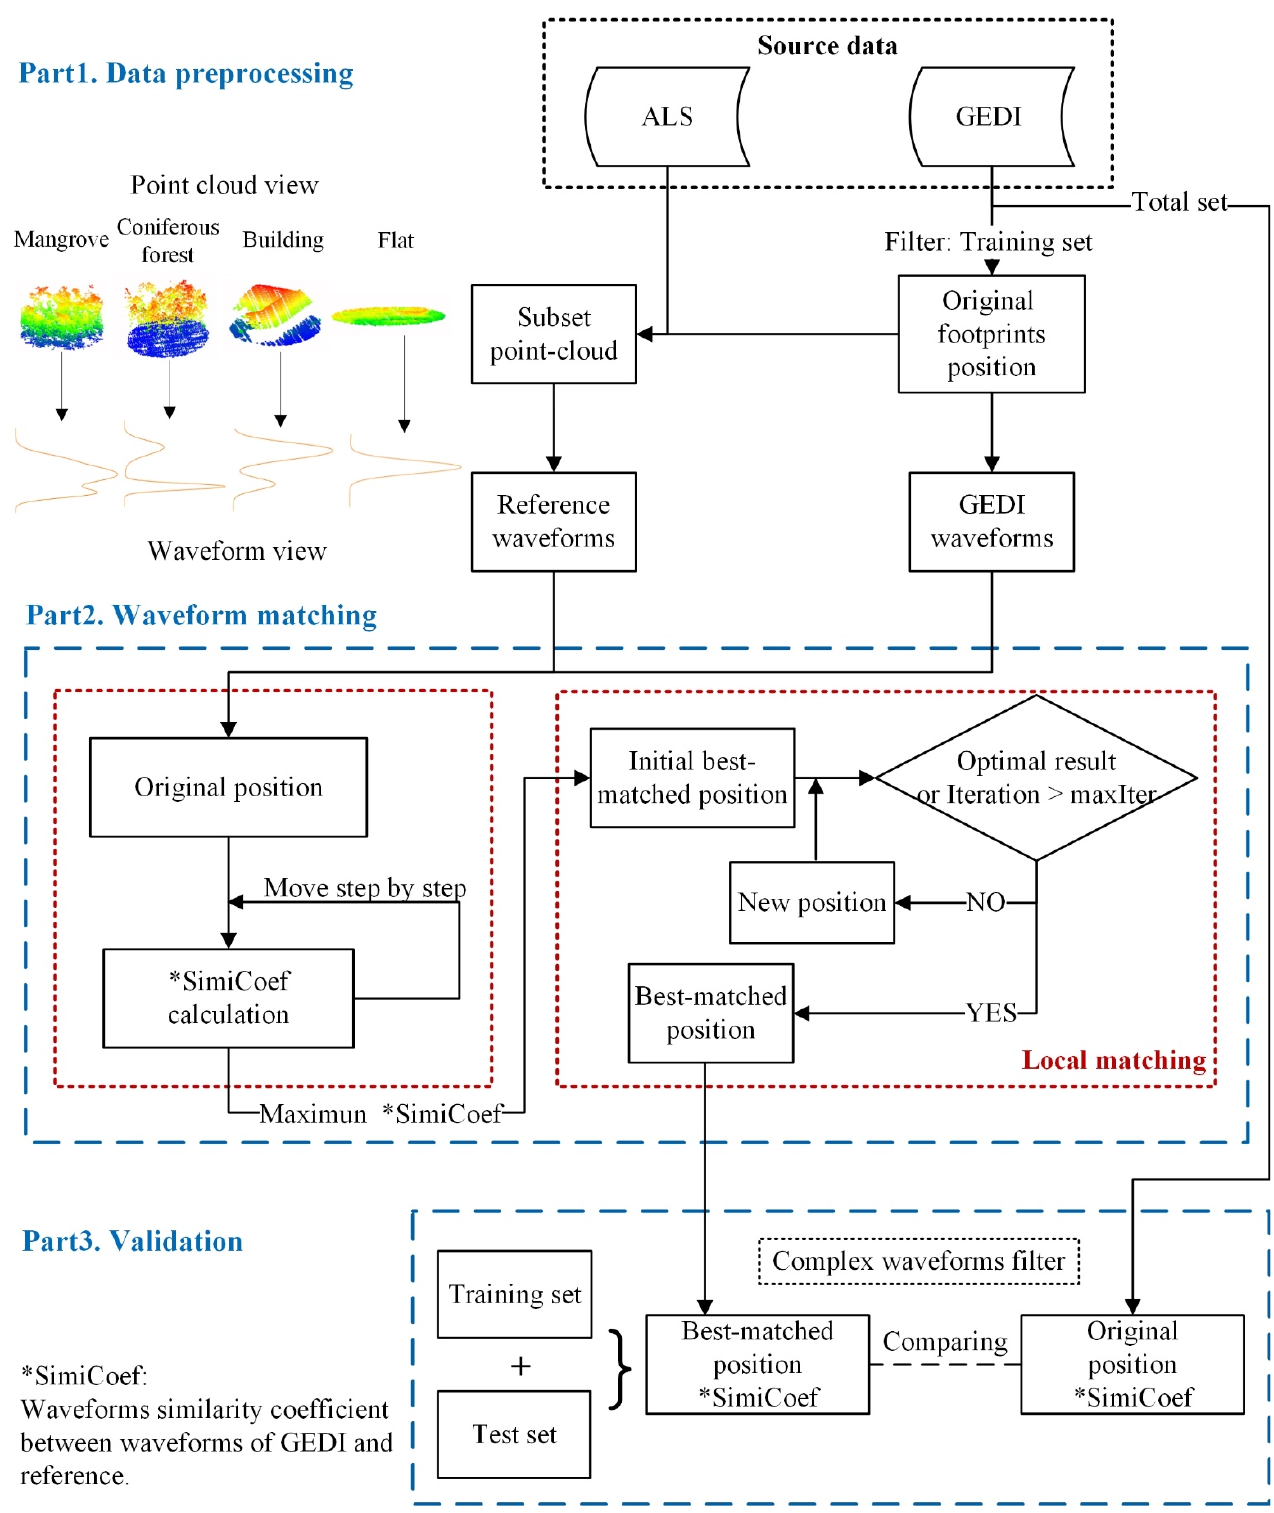
Figure 1. The work flowchart of single temporal GEDI footprint position correction based on the waveform matching method.